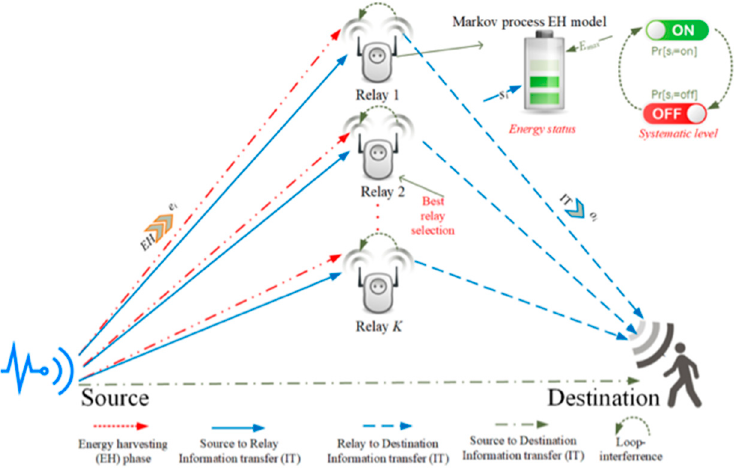
Figure 1. System